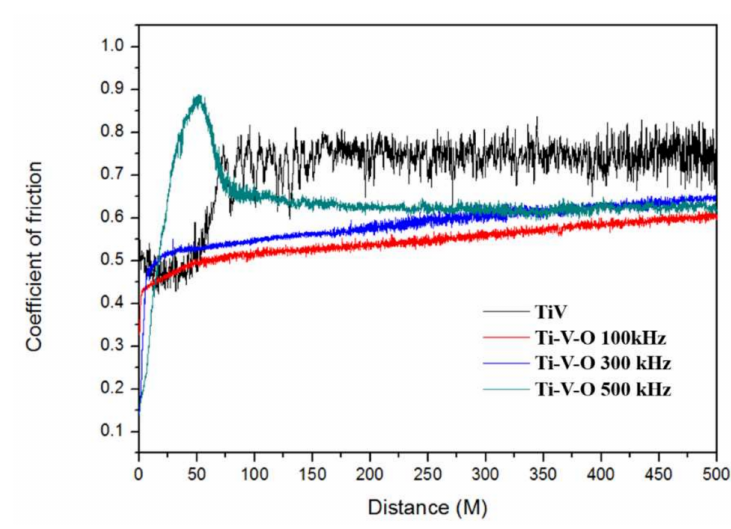
Figure 7. COF values of the TiV coating and LSTO Ti-V-O coating.